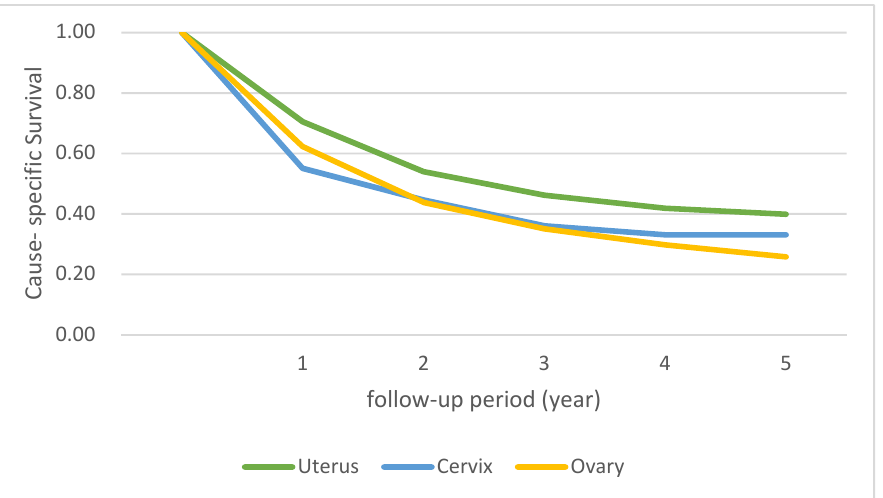
Figure 2. Comparison of cause-specific survival rates according to origin of gynecologic